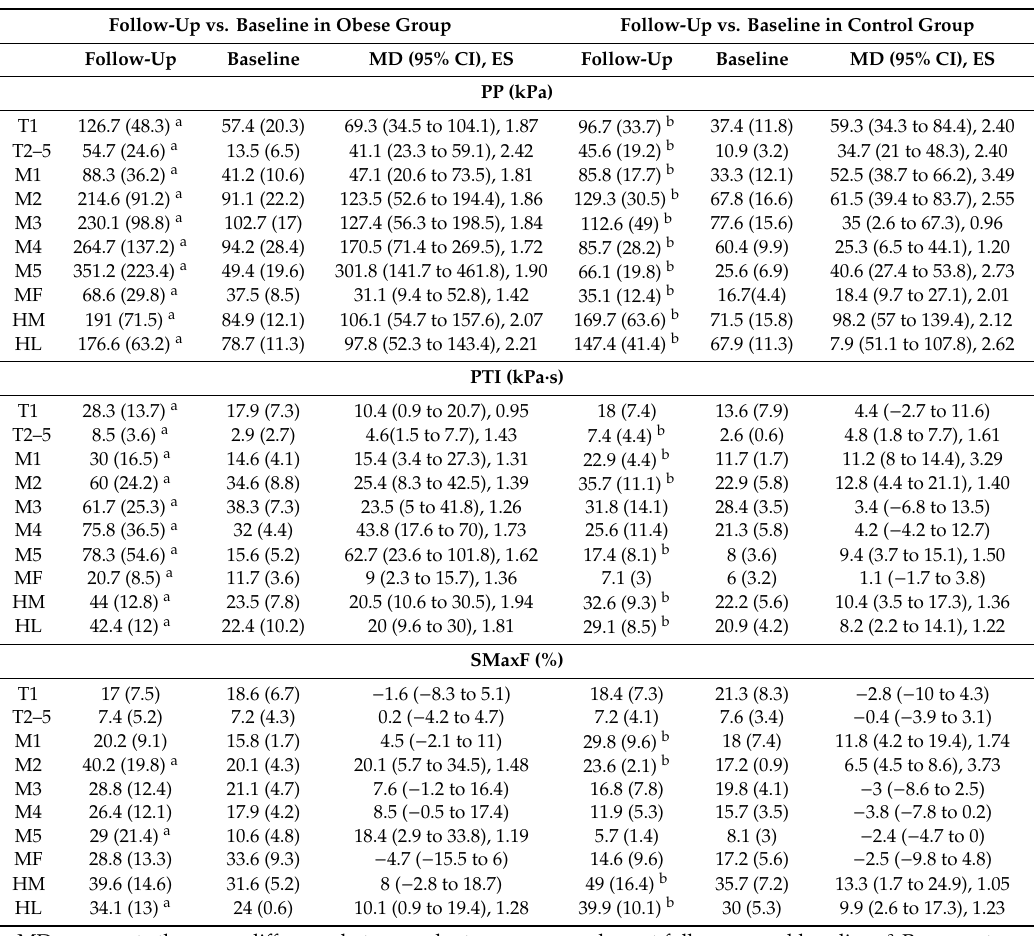
Table 2. Mean (SD) values for plantar pressures with MD (95% CI) and e ff ect sizes for significant di ff erence between follow-up and